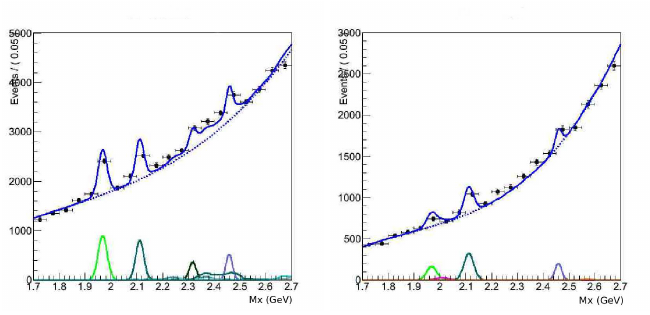
Figure 4. GMC fit results to the full range missing mass distribution for B + → ¯ D 0 D ( ∗ ) for B + → ¯ D ∗ 0 D ( ∗ ) (right). For both figures, the Gauss curves correspond to resonances of D s (light s ( J ) green), D ∗ (pink), D ∗ (dark green), D s 1 (2460) (purple); on the (a) graph an irregular structure describes s crossfeeds from channels B + → ¯ D ∗ 0 D ( ∗ ) and B 0 → D ∗− D ( ∗ ) . s ( J ) s ( J )